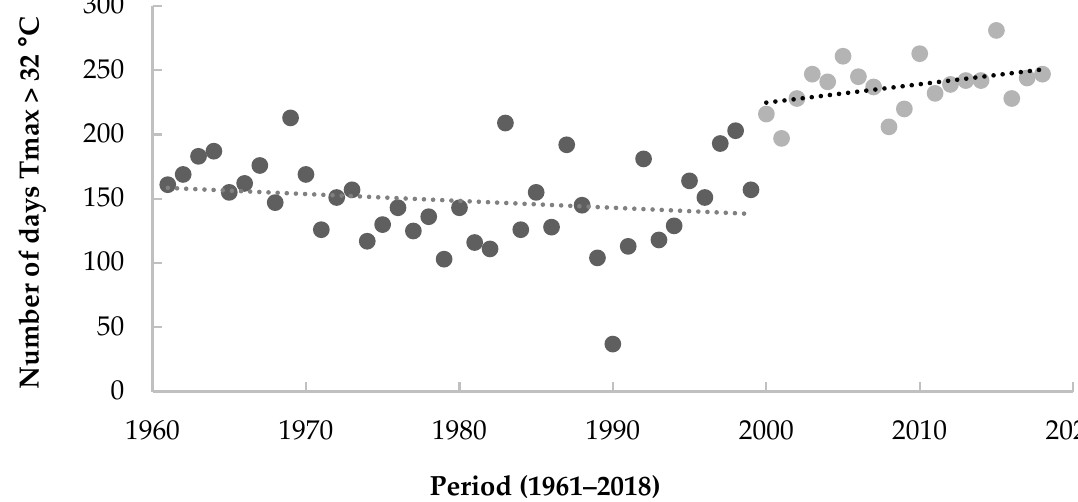
Figure 6. Distribution of days in the year with a maximum temperature above the average (32 °C). Data from INMET station 82331, 2020. Elaborated by authors.